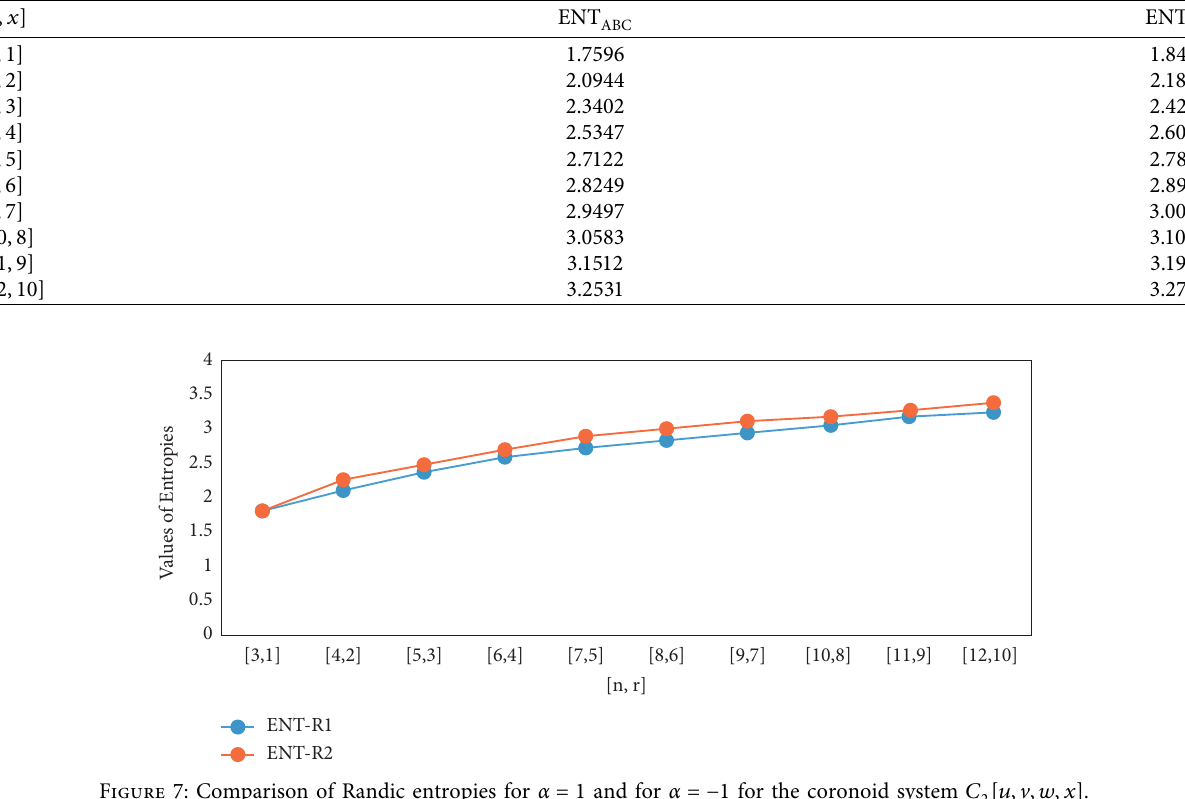
and ENT entropies for C ABC GA